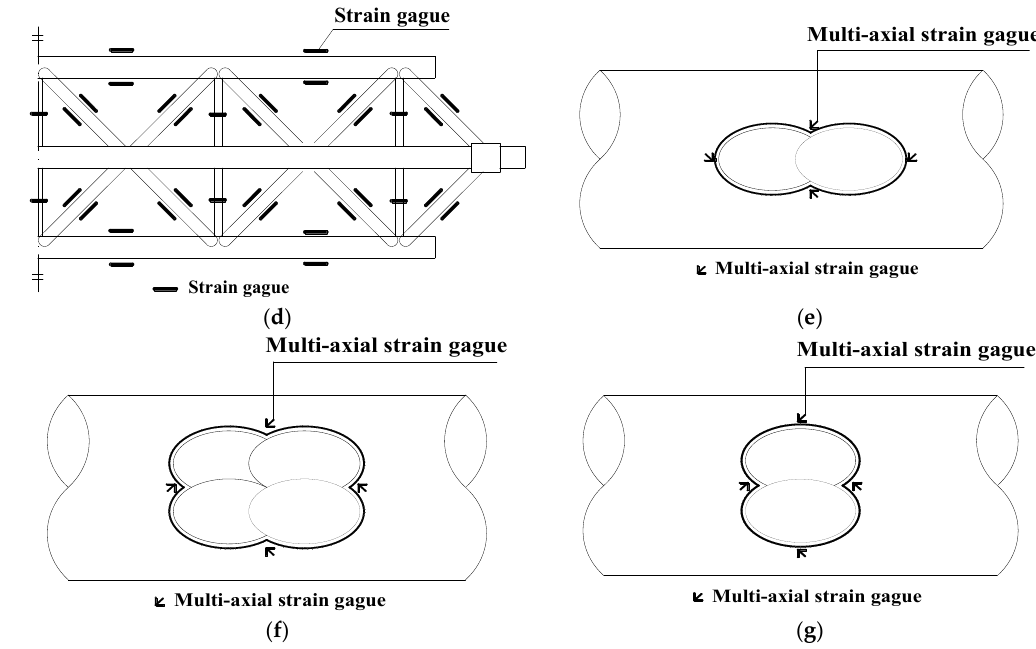
Figure 4. Arrangement of displacement transducers and strain gauges. ( a ) Arrangement of the displacement transducers; ( b ) Front view of single element strain gauges; ( c ) Top view of single element strain gauges; ( d ) Bottom view of single element strain gauges; ( e ) Joints of top chord; ( f ) Midspan joints of bottom chord; ( g ) End joints of bottom chord.